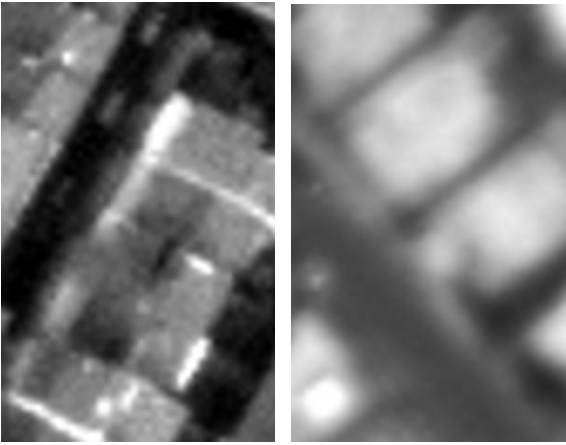
Figure 3 : example of PA defocused images